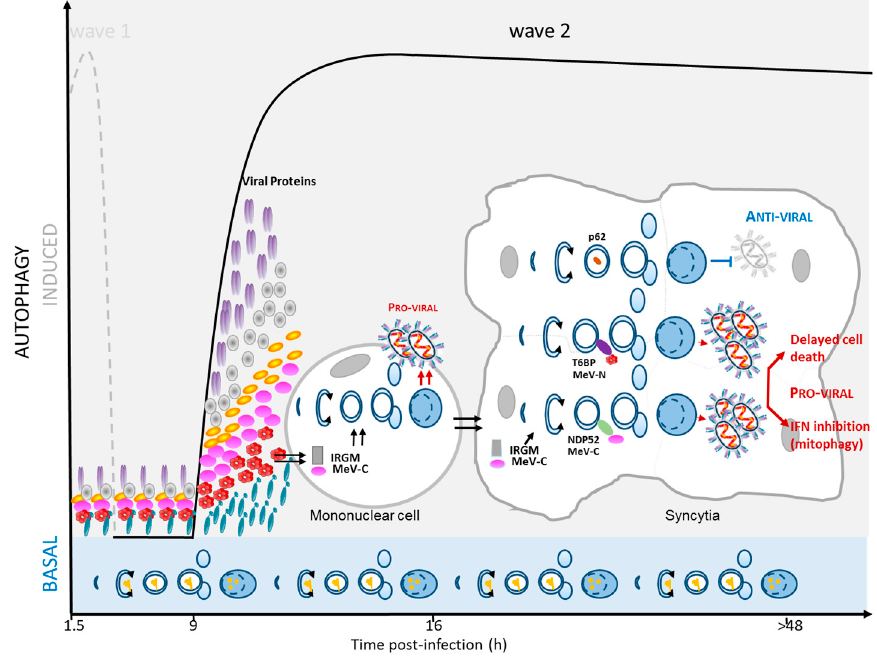
Figure 2. Second wave of autophagy induction upon MeV infection. After nine hours of MeV infection, a second autophagy wave is induced, which correlates with the accumulation of MeV proteins. Several successive signals seem associated with this late autophagy wave, including IRGM engagement and events associated with syncytia formation. Autophagosome maturation is required for an efficient MeV replication (pro-viral effect). This effect could involve the two autophagy adaptors NDP52 (Nuclear Dot 52 KDa Protein) and T6BP (TRAF6-Binding Protein), which are both targeted by MeV proteins. In contrast, p62 appears to oppose MeV replication (anti-viral effect). The pro-viral function of autophagy has been shown to involve a delayed death of infected cells and a decreased innate anti-viral response. (blue arrows = anti-viral effect; red arrows = pro-viral effect; dotted line = wave 1).